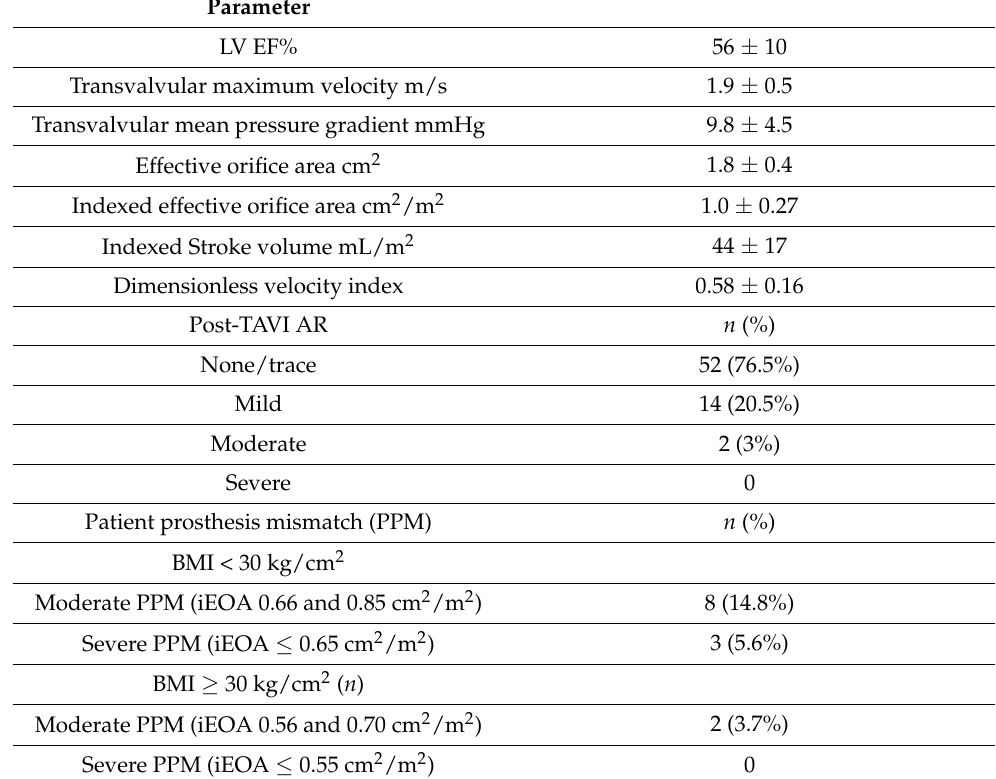
Table 5. Hemodynamic performance (echocardiographic assessment at 30 days) of the Myval THV in